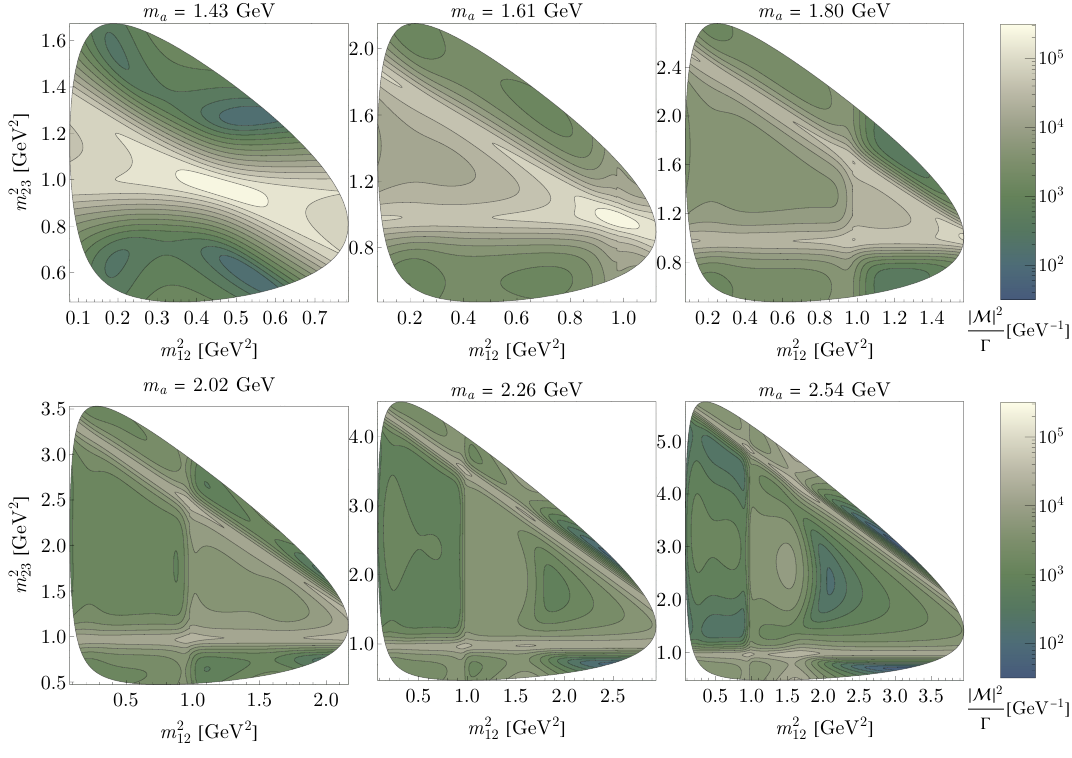
Figure 4 . Dalitz plot density for six values of ALP masses used for the a → π + π − η